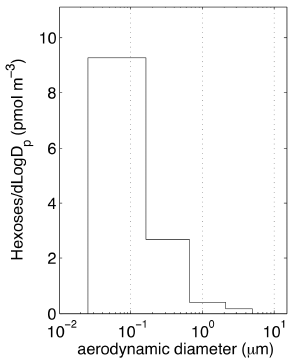
Fig. 6. Mass size distribution of particulate hexose monomers for trajectory cluster 4a during